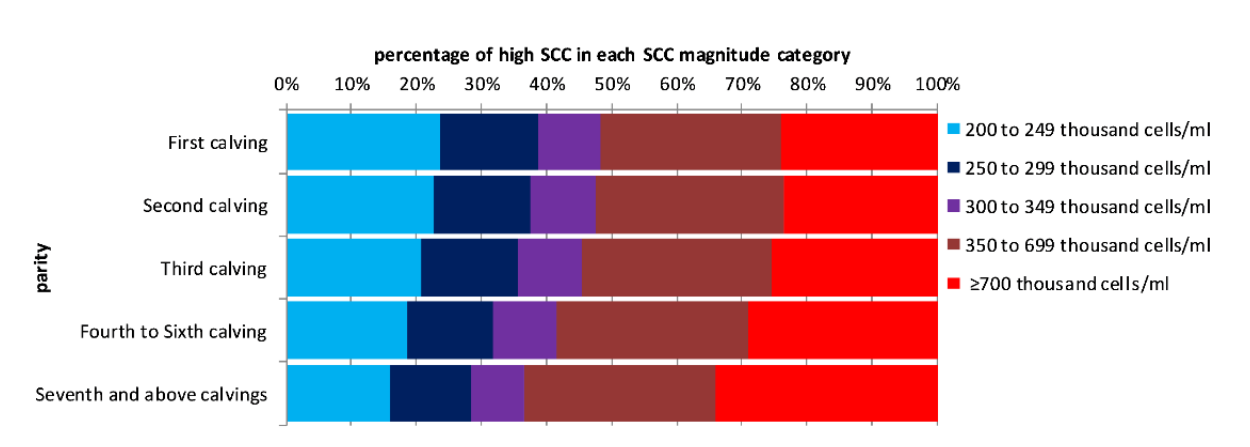
Figure 2: Distribution of high SCC MRs between SCC magnitude categories for different parities On aggregate, 29% of high SCC in parity 3 and above had a magnitude of ≥700 thousand cells/ml, compared with 23% in second parity and 24% in first parity. The proportions of lower magnitude SCC categories tend to decrease and higher magnitude SCC categories tend to increase with increasing parity. This is in parallel with progressively lower recovery probability with increasing parity (Table 2).